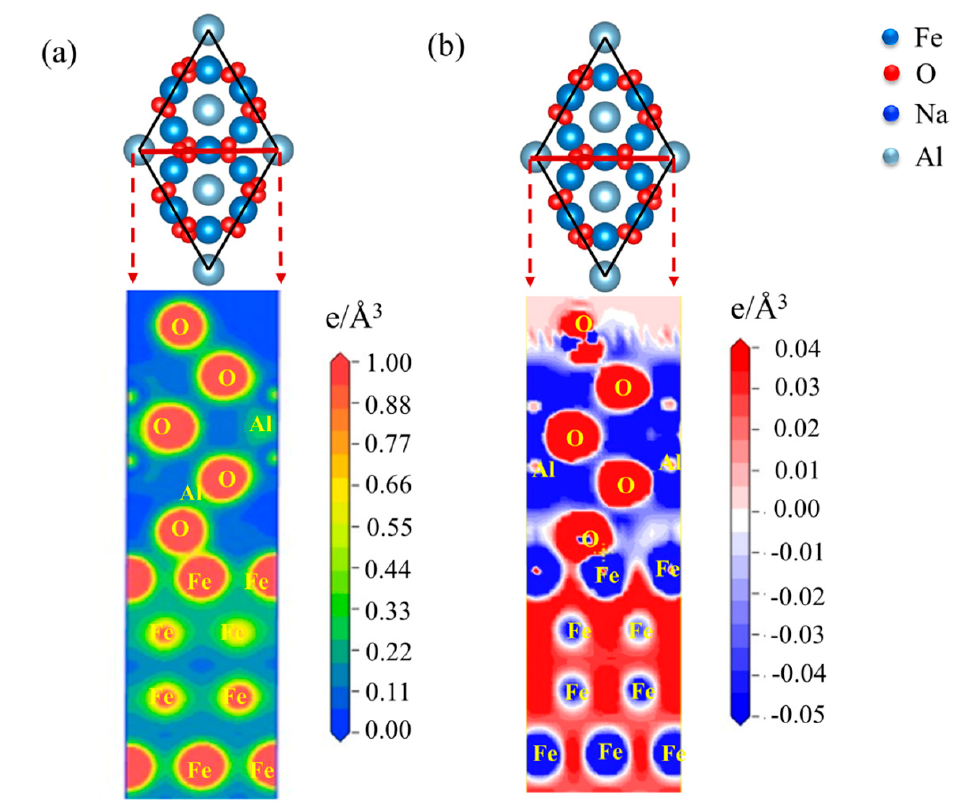
Figure 9. The ( a ) charge density and ( b ) charge density difference of the Fe-Al 2 O 3 interface at (001) crystal plane.